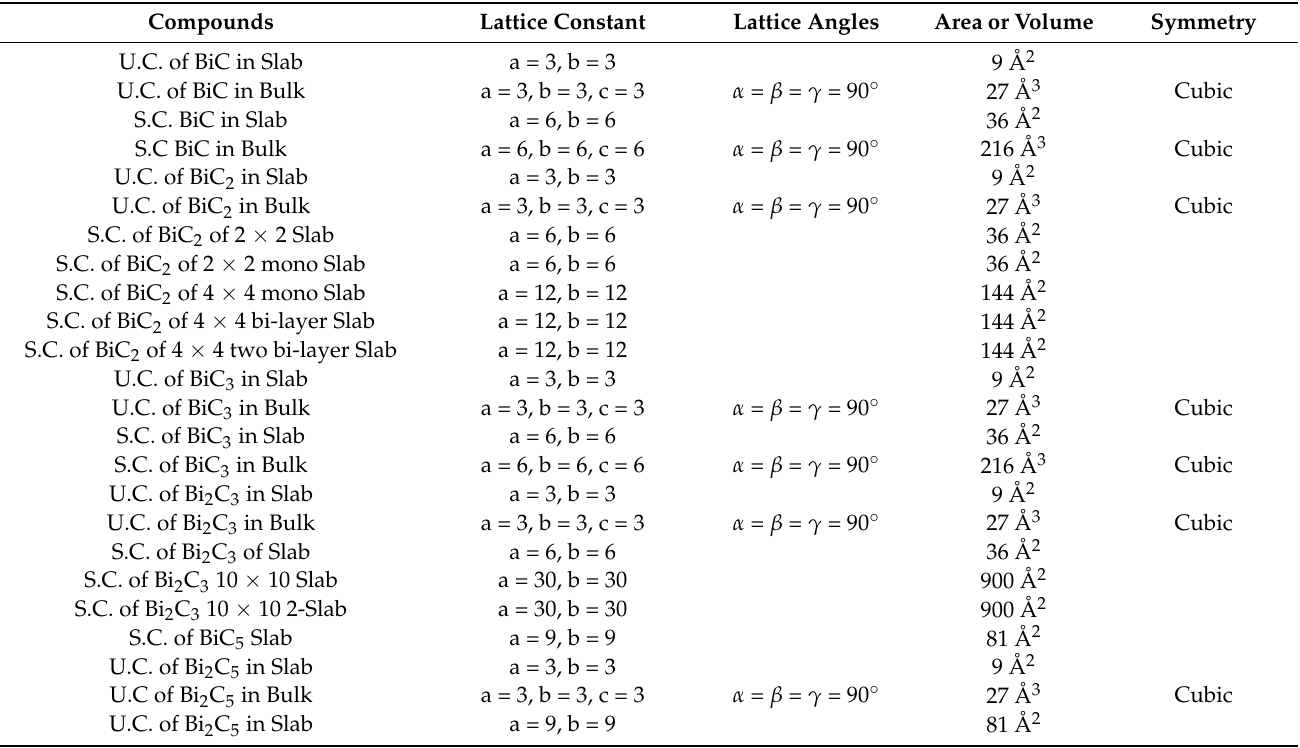
Table 1. The optimized values of lattice Constant, Angles, Area/Volume, and Symmetry of Com- pounds in unit cell (U.C.) and supercell (S.C.) geometries. Compounds Lattice Constant Lattice Angles Area or Volume